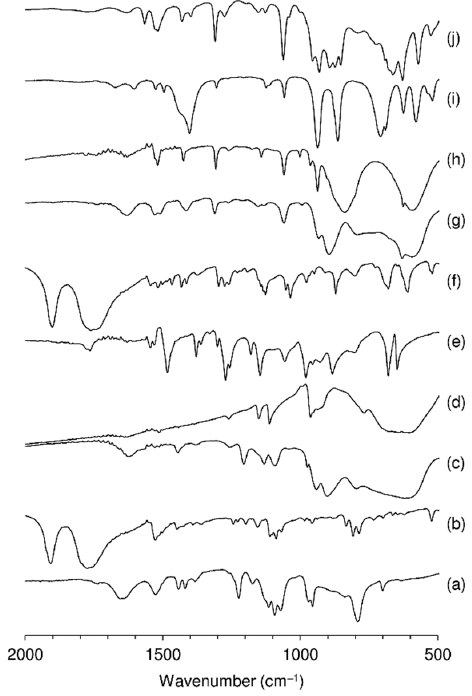
Figure 1. FT-IR spectra in the range of 500-2000 cm ‒ 1 of ( a ) 1,2,3-trz, ( b ) tricarbonyl complex 1 , ( c ) oxidized derivative 1 OD , ( d ) hybrid 3 , ( e ) 1,2,4-trz, ( f ) tricarbonyl complex 2 , ( g ) oxidized derivative 2 OD , ( h ) hybrid 4 , ( i ) dinuclear complex 5 , and ( j ) trinuclear complex 6 (from ref. [26]).